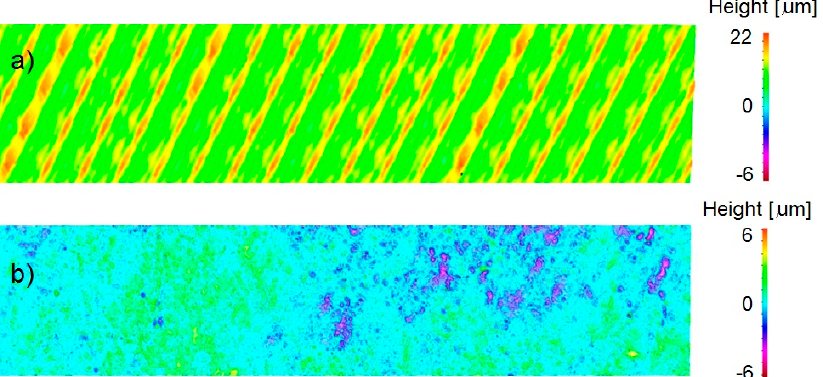
Figure 23. A comparison of the surfaces. ( a ) before ironing ( b ) after linear ironing with the preheated iron cylinder. Table 2. Average surface roughness after machining and thermal ironing.